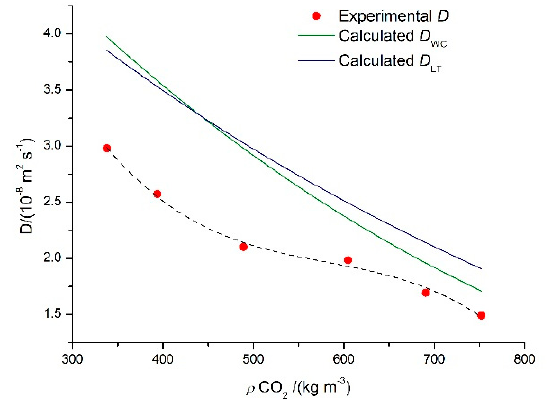
Figure 6. Experimental and calculated diffusion coefficient for ethanol in scCO 2 at pressure p = 10.5 MPa and temperatures from 306.15 to 331.15 K .